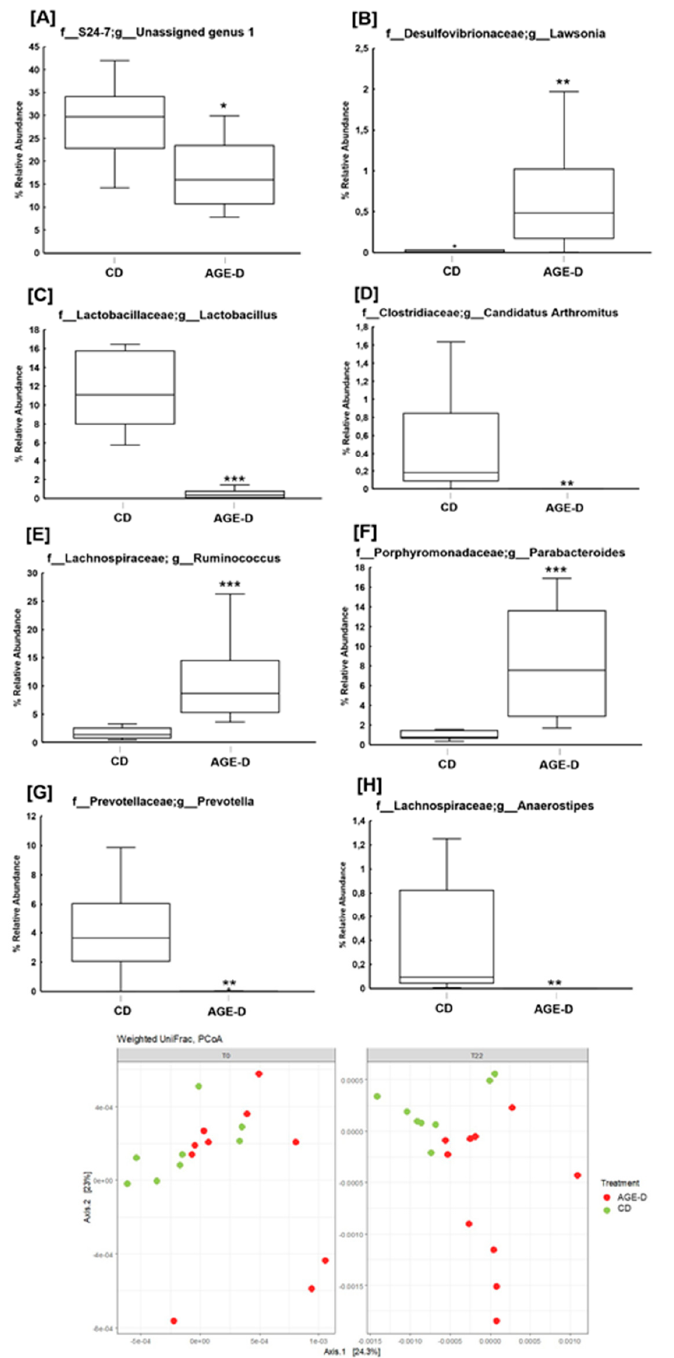
Figure 6. ( A – H ) Boxplots of percentage relative abundance of fecal microbial genera in CD ( n = 8) and AGE-D ( n = 10) mice at 22 weeks (T22) of dietary intervention after 16SrRNA sequencing using V3-V4 targeted primers. “Unidentified genus 1”: a genus within the Family S 24-7 which could not be assigned at a percentage sequence homology of at least 95% to any existing genera within the reference database (http: // greengenes.lbl.gov). ( I ) Beta-diversity of microbial populations in CD and AGE-D at T0 and T22, according with Weighted UniFrac analysis. Statistical significance: * p < 0.05, ** p < 0.01, *** p <